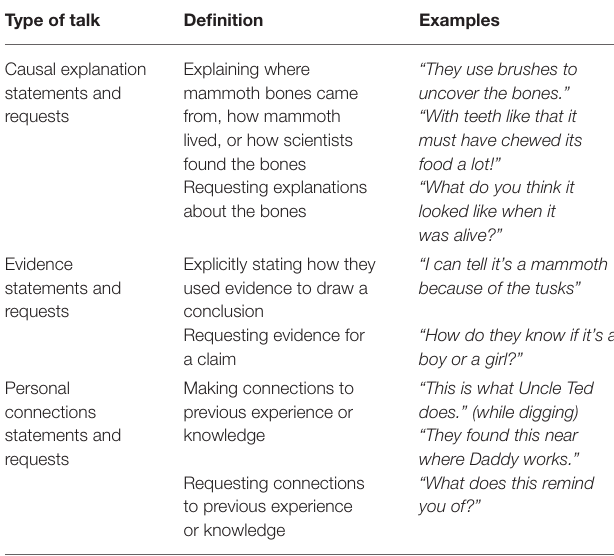
TABLE 2 | Coding categories for parents’ and children’s explanatory science talk at the 8 fossil and replica bone exhibits (coded in number of